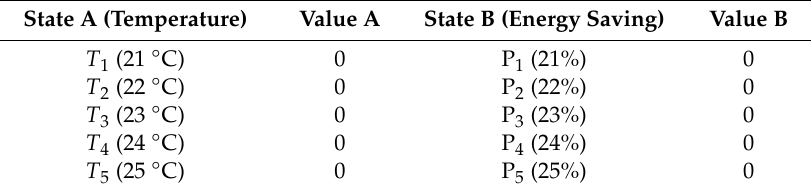
Table 12. Initial random value function of RL-based BEMS.